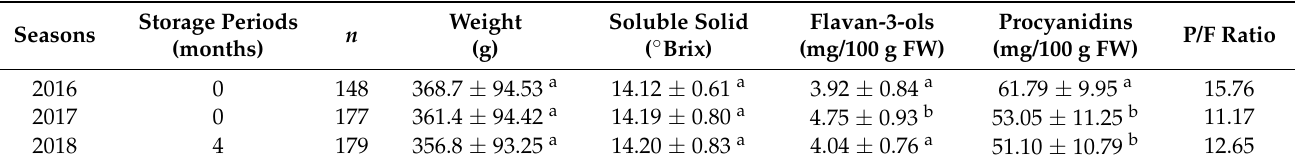
Table 4. Concentrations of the flavan-3-ols and procyanidins in non-bagged ‘Orin’ apples that were harvested during the 2016–2018